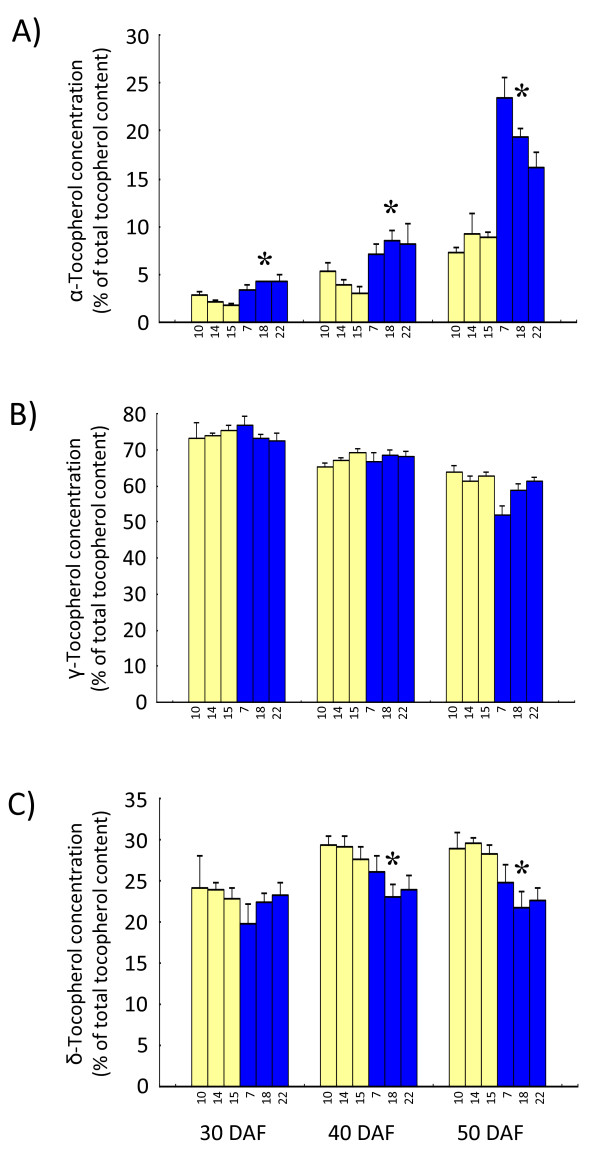
Tocopherol concentration in developing seeds of HIF-derived lines. Developing seeds of HIF-derived lines homozygous for either the Ichihime allele for γ-TMT3 (F5-24-10, F5-24-14, and F5-24-15; yellow bars) or the KAS allele for γ-TMT3 (F5-24-7, F5-24-18, and F5-24-22; blue bars) were used for analysis. Seeds were analyzed at 30 days after flowering (DAF), 40 DAF, and 50 DAF. The concentrations of α-tocopherol (A), γ-tocopherol (B), and δ-tocopherol (C) were calculated as the percentage of the tocopherol isoform in total tocopherol content. Data are represented as mean ± SD of the values obtained from triplicate experiments. For each developmental stage, significant differences between the Ichihime genotype group and the KAS genotype group (confidence interval 95%) are shown with asterisks.